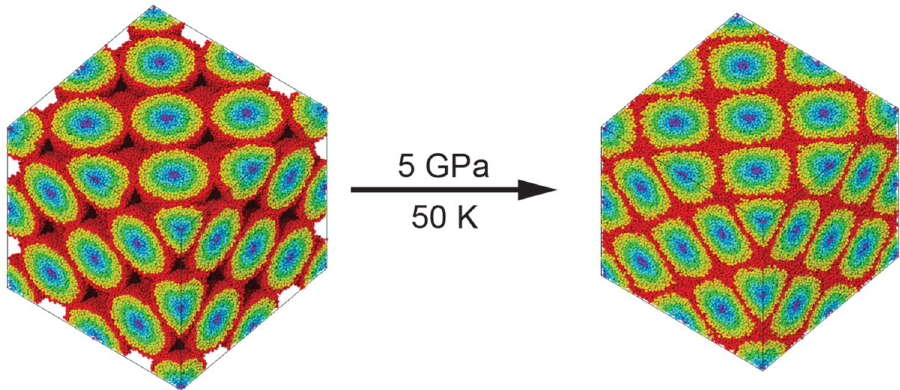
Figure 3. Illustration of the FCC-NG model before and after cold compression with atoms colored according to their initial position in a 7-layered shell structure from the core of each nanoparticle (dark blue) to its surface (red). Images created with OVITO version 3.5.3, https:// www. ovito.